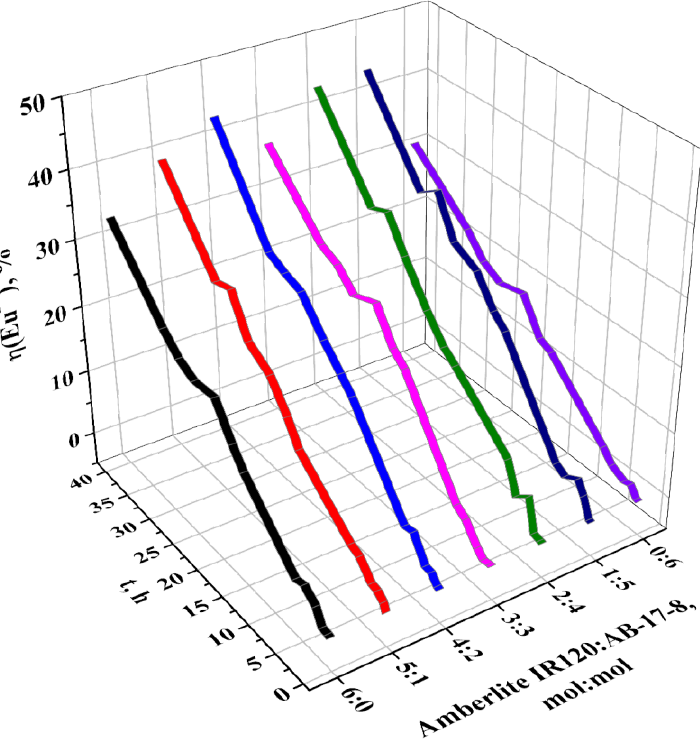
Figure 5. Extraction degree of Eu 3+ ions in dependence from molar ratios and time.